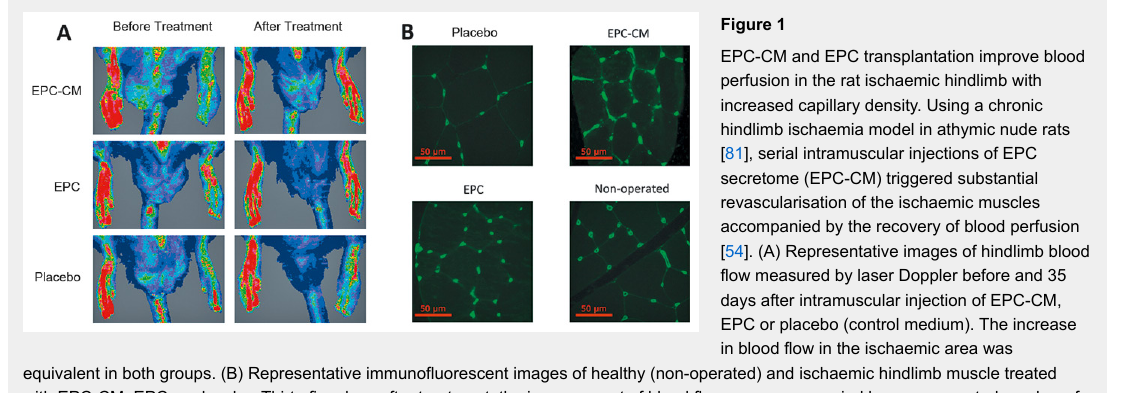
equivalent in both groups. (B) Representative immunofluorescent images of healthy (non-operated) and ischaemic hindlimb muscle treated with EPC-CM, EPC or placebo. Thirty-five days after treatment, the improvement of blood flow was accompanied by an augmented number of capillaries in both, the EPC and EPC-CM group indicative of increased neovascularisation. Images adapted from Di Santo S, et al., PLoS